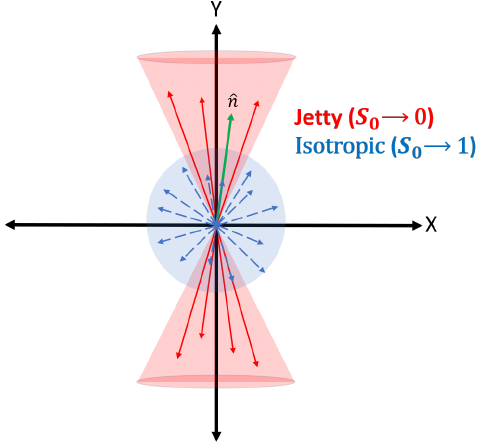
Figure 2. Jetty and isotropic events in the transverse